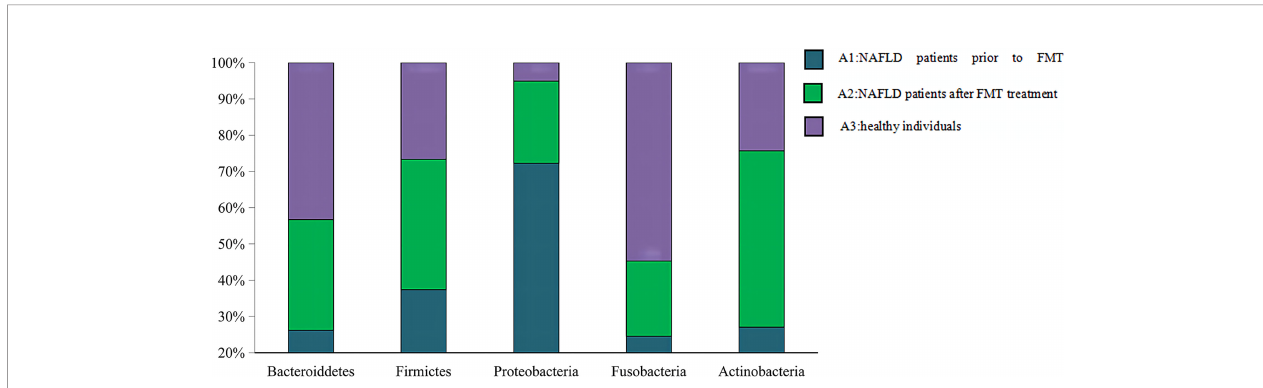
FIGURE 4 | Percentage of each phylum in patients with non-alcoholic fatty liver disease (NAFLD) and healthy individuals. An increasing trend of Bacteroidetes and Bacteroidetes/Firmicutes (B/F) ratio was observed from the pre-fecal microbiota transplantation (pri-FMT) group to the healthy